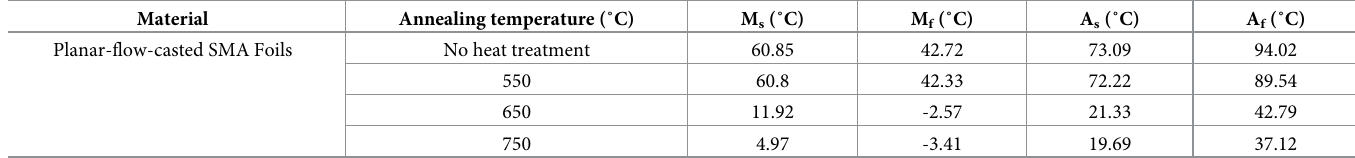
Table 1. The heat treatment of the SMA foils was conducted at 550˚C, 650˚C and 750˚C, respectively, for 30 minutes under argon before quenching in water. The transformation temperatures Ms, Mf, As, Af of both planar-flow-cast SMA foil samples annealed at different temperatures.